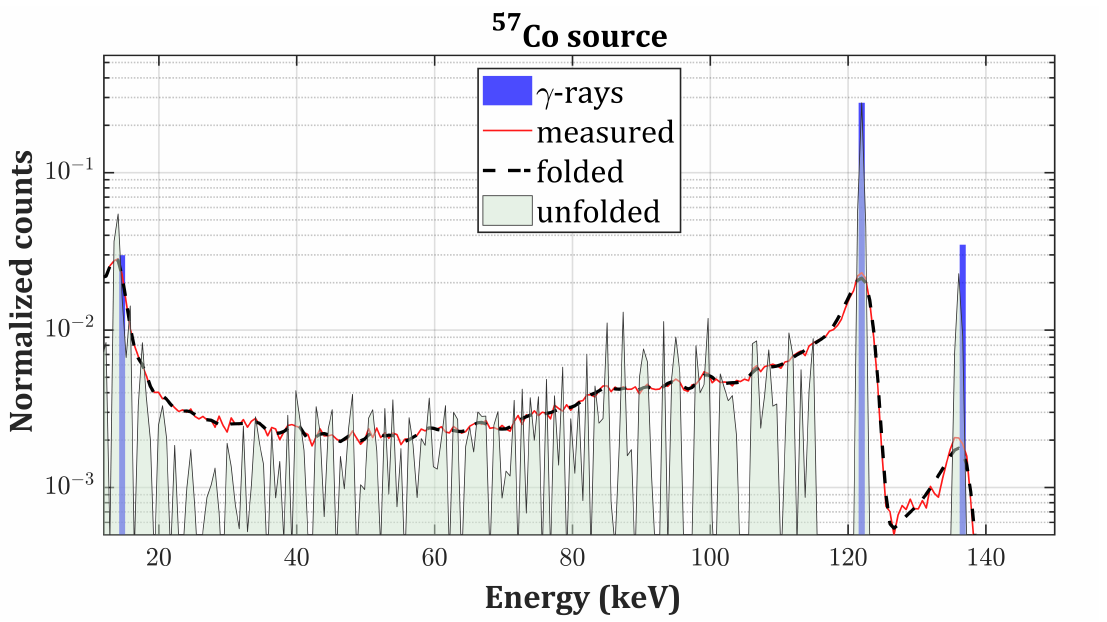
Figure 7. 57 Co unfolded spectrum (gray curve) compared to the measured spectrum (red curve), the folded spectrum (black dashed curve) and the tabulated intensities of the γ -emissions (blue bars) of 57 Co on a logarithmic scale.